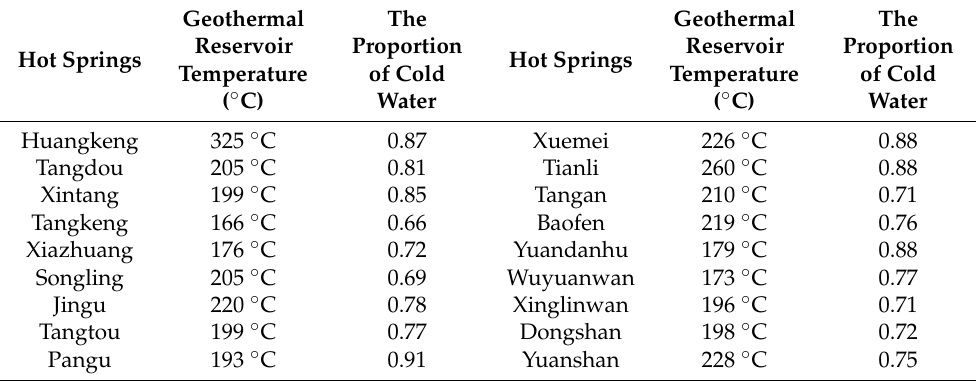
Figure 8. Graphical representation of the ratio of deep hot water temperature to mixed cold water in the study area (( a ) — Huangkeng; ( b ) — Tangdou; ( c ) — Xintang; ( d ) — Tangkeng; ( e ) — Xiazhuang; ( f ) — Songling; ( g ) — Jingu; ( h ) — Tangtou; ( i ) — Pangu; ( j ) — Xuemei; ( k ) — Tianli; ( l ) — Tangan; ( m ) — Baofen; ( n ) — Yuandanhu; ( o ) — Wuyuanwan; ( p ) — Xinlinwan; ( q ) — Dongshan; ( r ) — Yuanshan). Table 3. Geothermal reservoir temperatures and the proportion of cold water mixed for the hot springs obtained from the mixing